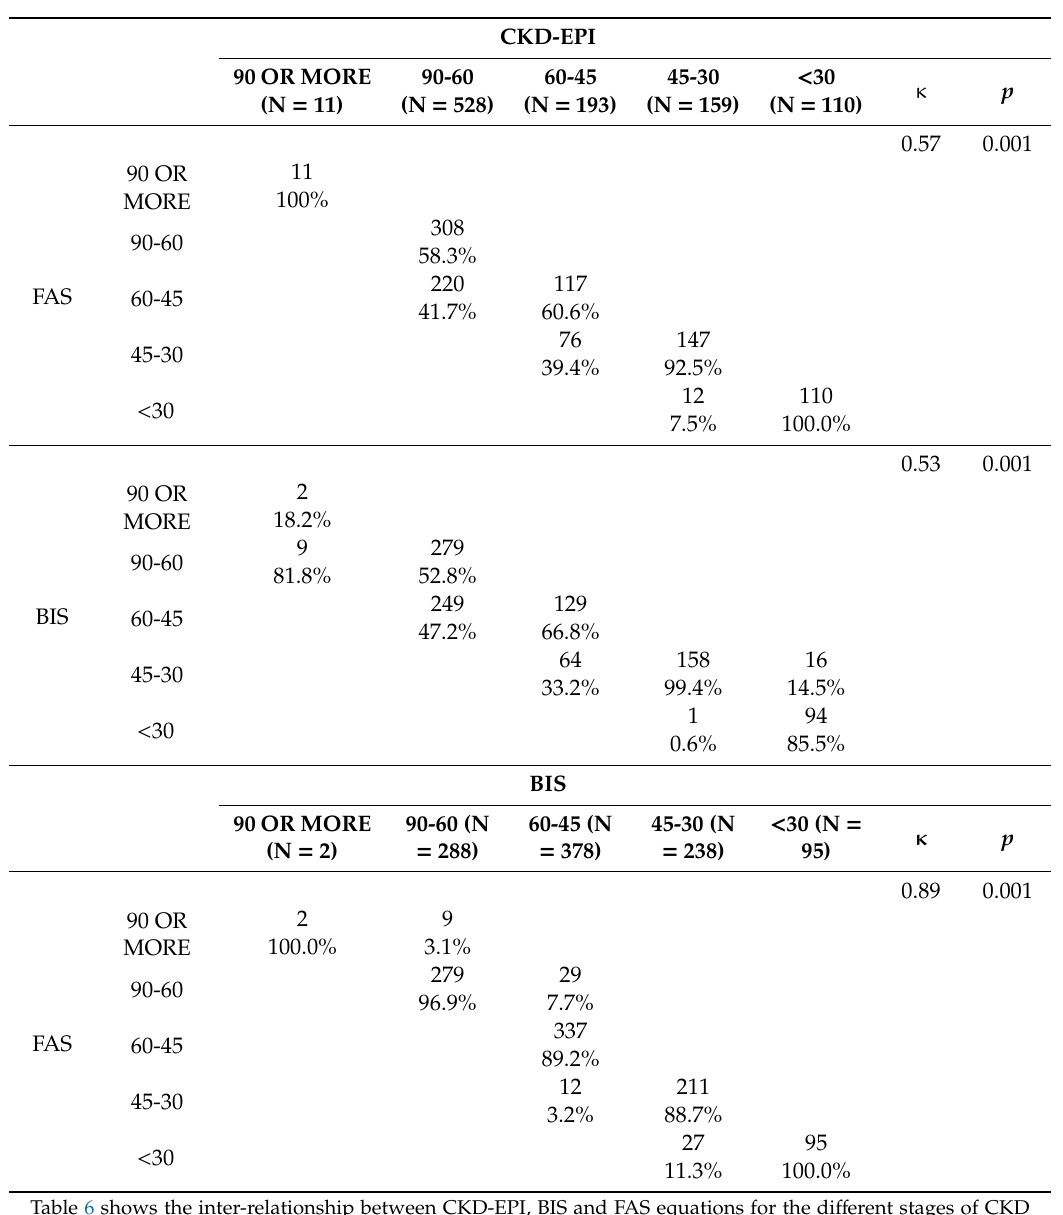
Table 6. Agreement among eGFR equations studied in men comparing CKD-EPI, BIS and FAS